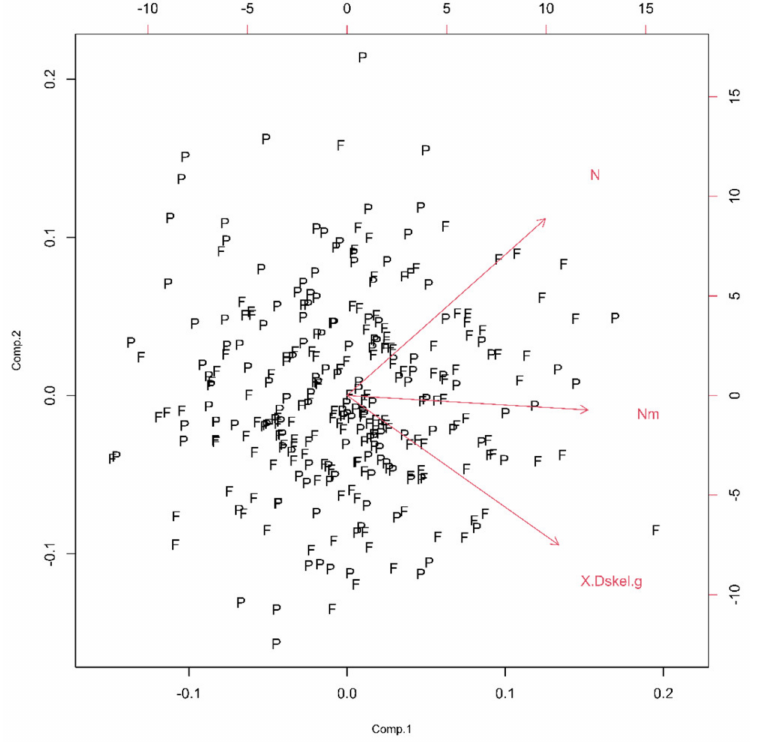
Figure 7. The PCA-based bi-plots of parameters characterizing morphological features in the given parameter space. Relationships between first two standardized principal components of the